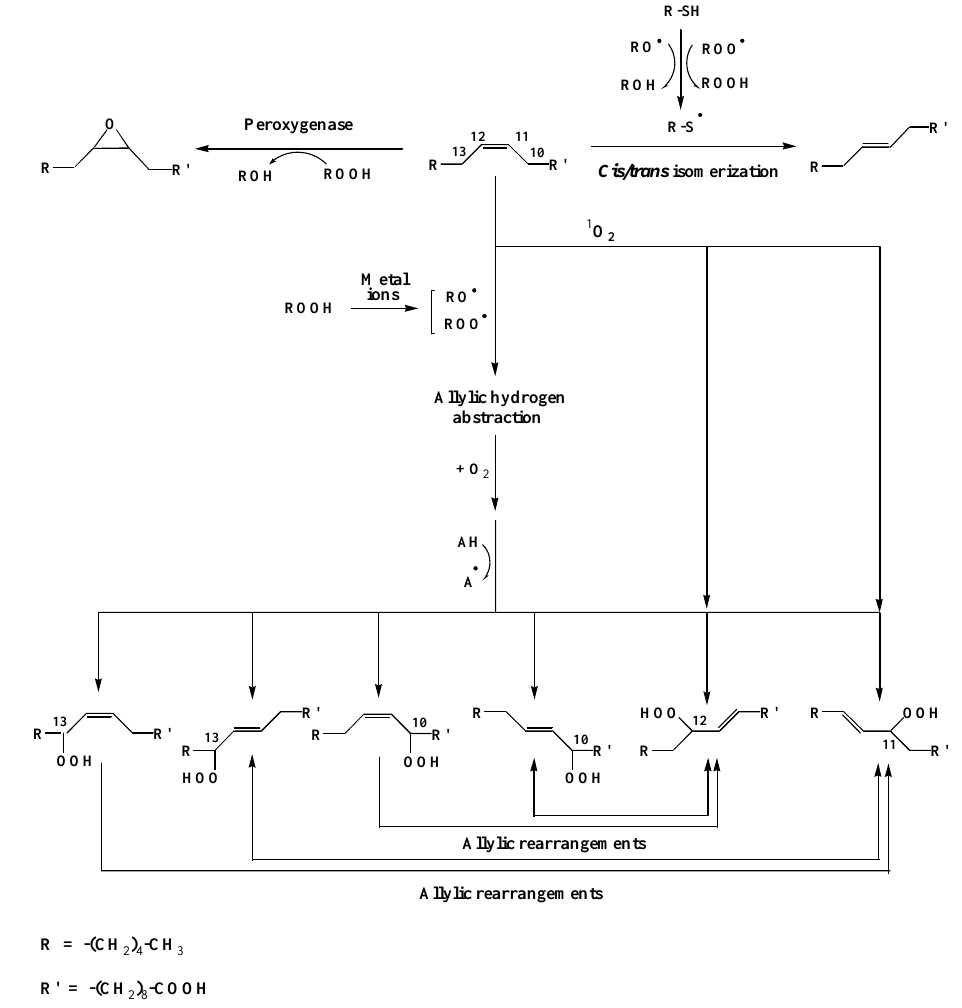
Fig. 9. Proposed mechanisms for biotic and abiotic degradation of vaccenic acid in the Beaufort Shelf.